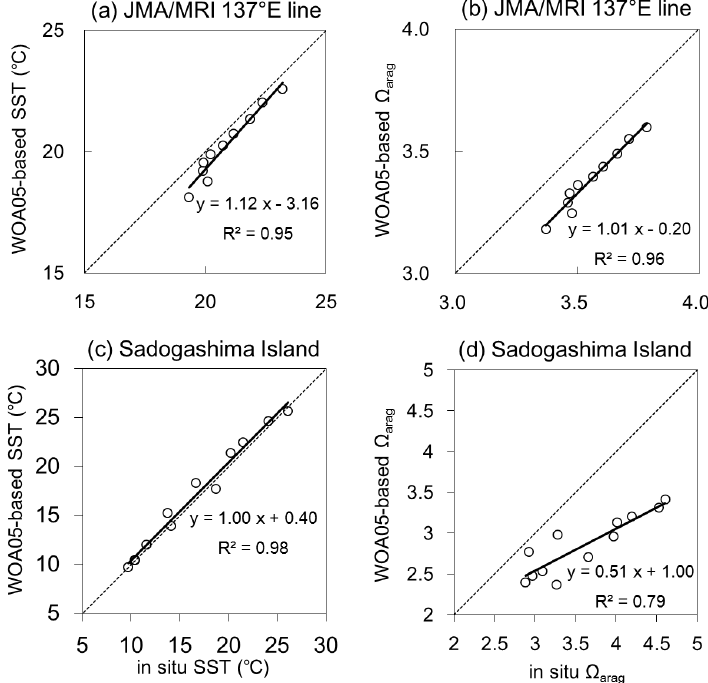
Figure 2 (Yara et al., 2012) Fig. 2. WOA05-based monthly climatology vs. in situ diagram of (a) monthly SST and (b) monthly (cid:127) arag on the JMA/MRI transect from 24 ◦ N/137 ◦ E to 33 ◦ N/137 ◦ E in winter (January and February), and (c) monthly SST and (d) monthly (cid:127) arag in Sadogashima Is- land (138.2 ◦ E, 38.0 ◦ N) for 2005–2009, respectively. In situ data are based on Midorikawa et al. (2010) and Ishii et al. (2011) for (a) and (b) , and Niigata Prefectural Fisheries and Marine Research Institute (2007, 2008, 2009, and 2010) for (c) and (d) , respectively. A dotted line in each figure is a 1 : 1